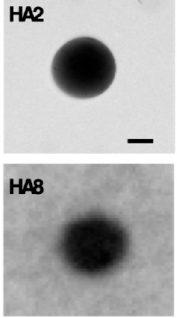
Figure 15. TEM images of HA2 and HA8 NPs.